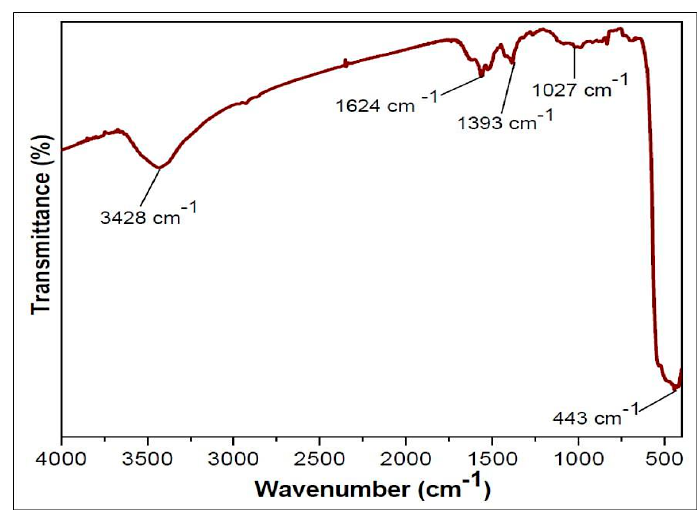
Figure 4. FTIR spectrum of ZnO NPs.